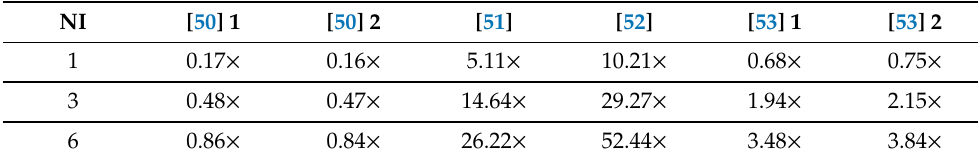
Table 12. Speedup comparison of the MLP-BP implementation with other works.